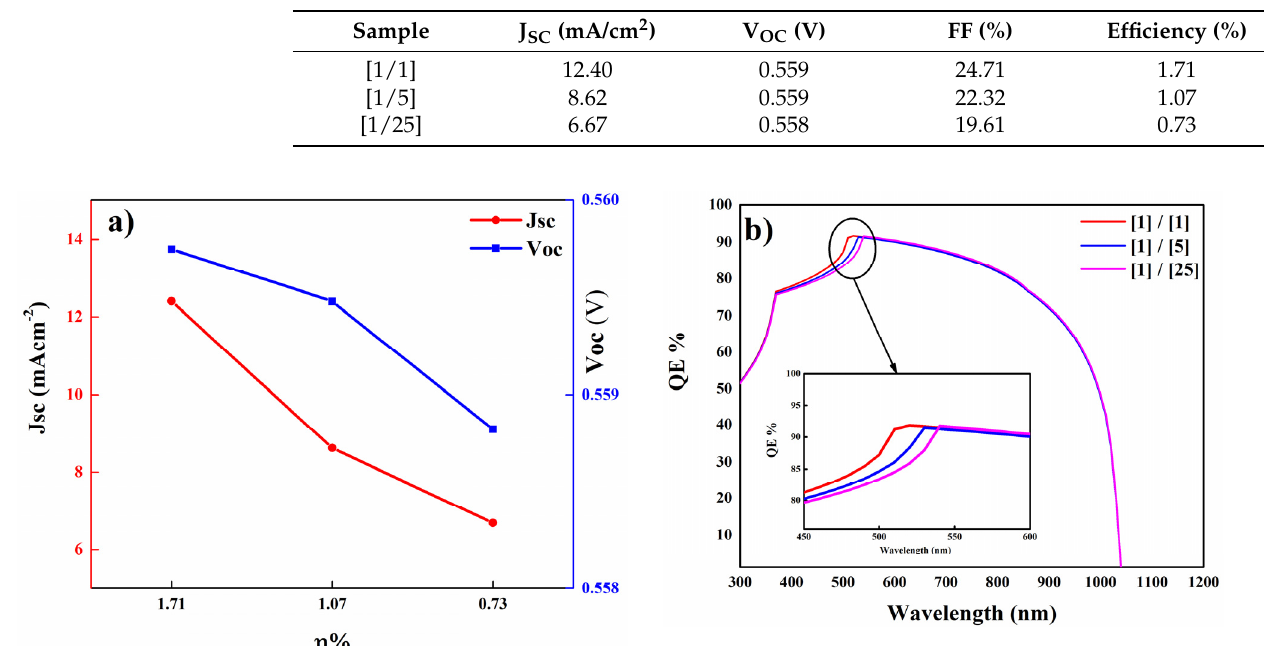
Figure 14. CIGS solar cells with different Cd/S ratio at; ( a ) Photovoltaic performance parameters, ( b ) QE %.